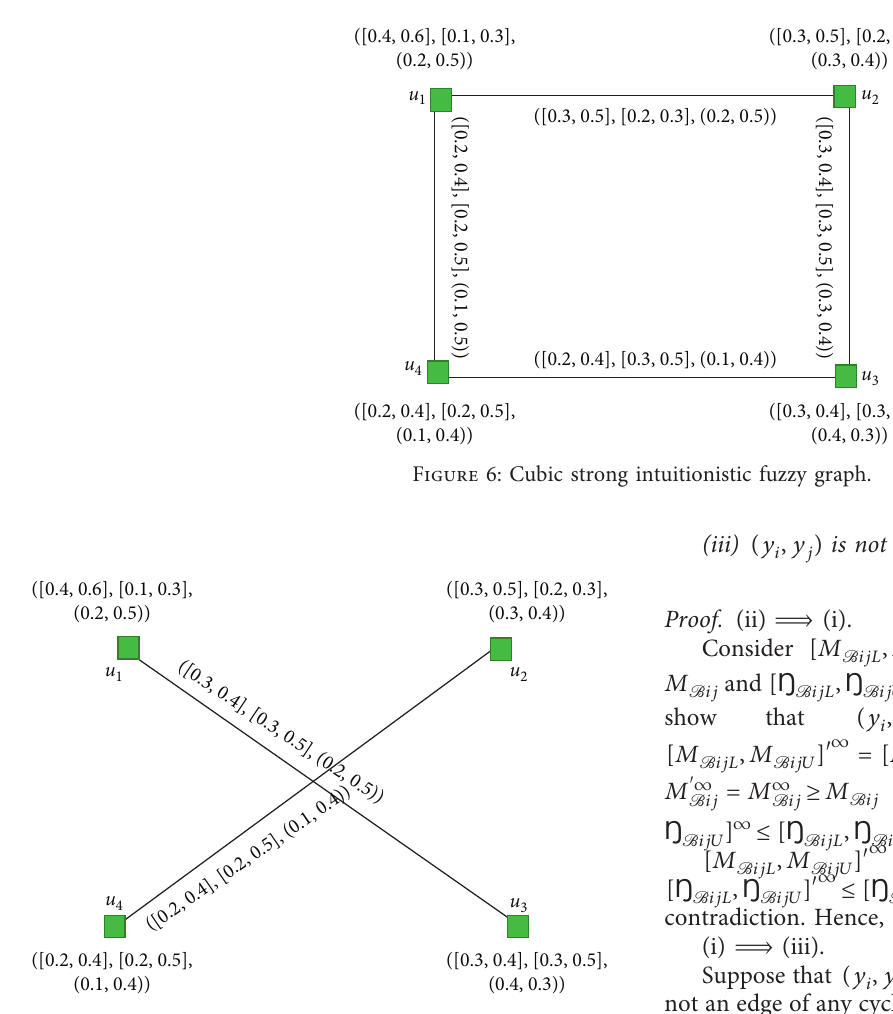
Figure 7: Complement of cubic strong intuitionistic fuzzy